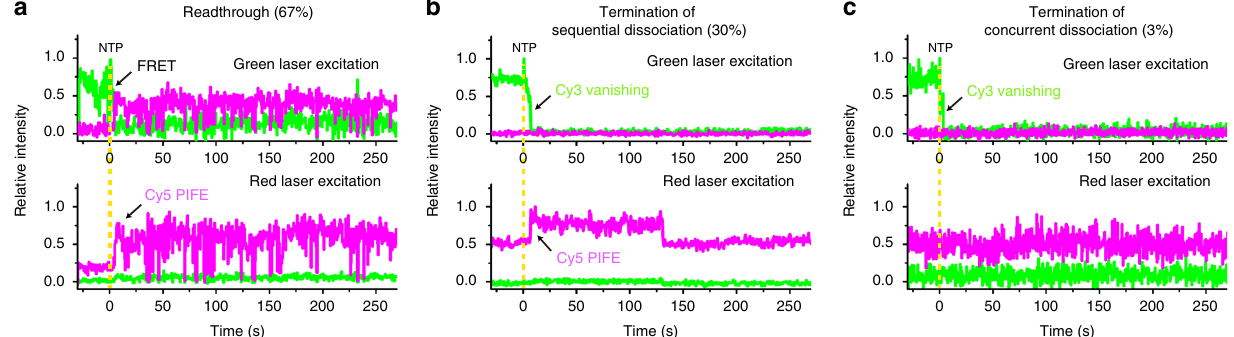
Fig. 2 Representative fl uorescence traces at green and red laser excitations. a In the readthrough events, RNAP reaches the downstream end of DNA without releasing RNA, showing both protein-induced fl uorescence enhancement (PIFE) of Cy5 and fl uorescence resonance energy transfer (FRET) from Cy3 to Cy5. b , c Among the remaining termination events, which show the release of Cy3-RNA, 91% retain RNAP on DNA showing Cy5 PIFE b , and 9% show RNAP dissociation without Cy5 PIFE c . Yellow vertical lines indicate NTP addition